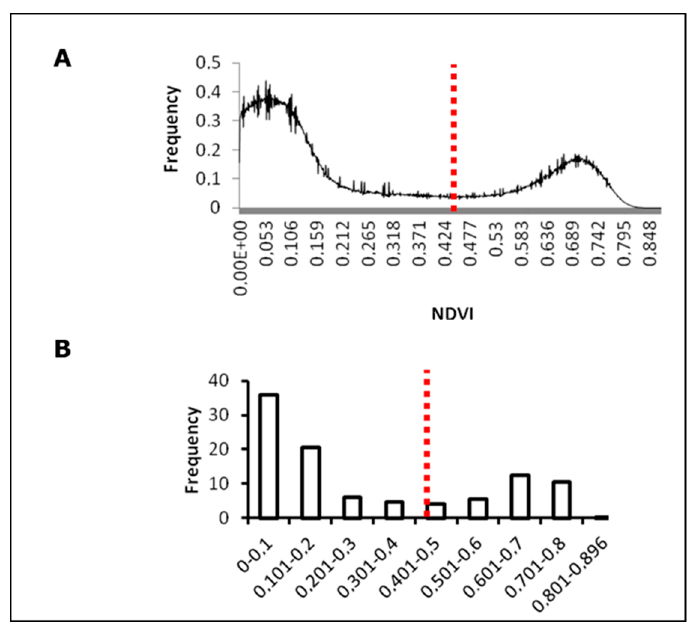
Figure 2. NDVI (Normalized Difference Vegetation Index) values distribution for soil-canopy pixels distinction. ( A ) NDVI frequency graph. ( B ) NDVI-ranged frequencies graph. Red line shows the NDVI threshold to separate canopy from soil.